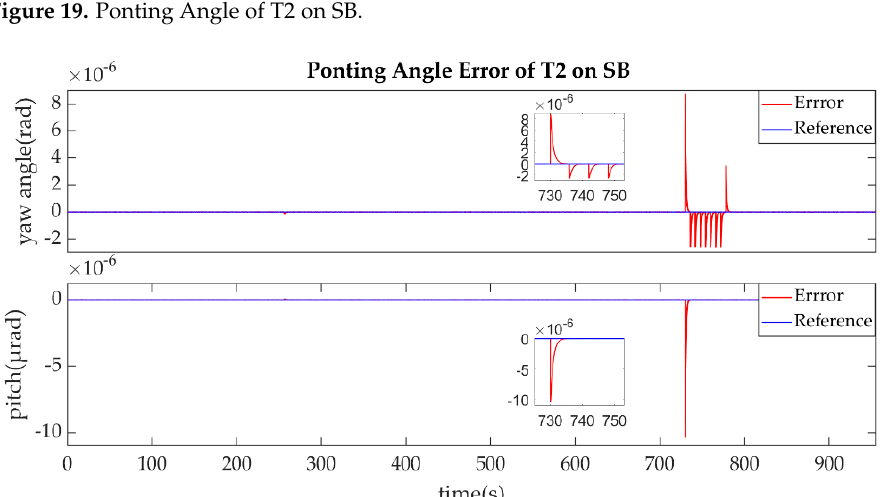
Figure 20. Ponting Angle Error of T2 on SB.